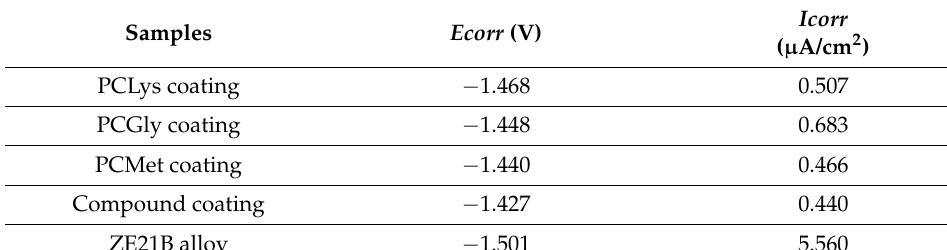
Table 4. Electrochemical parameters.